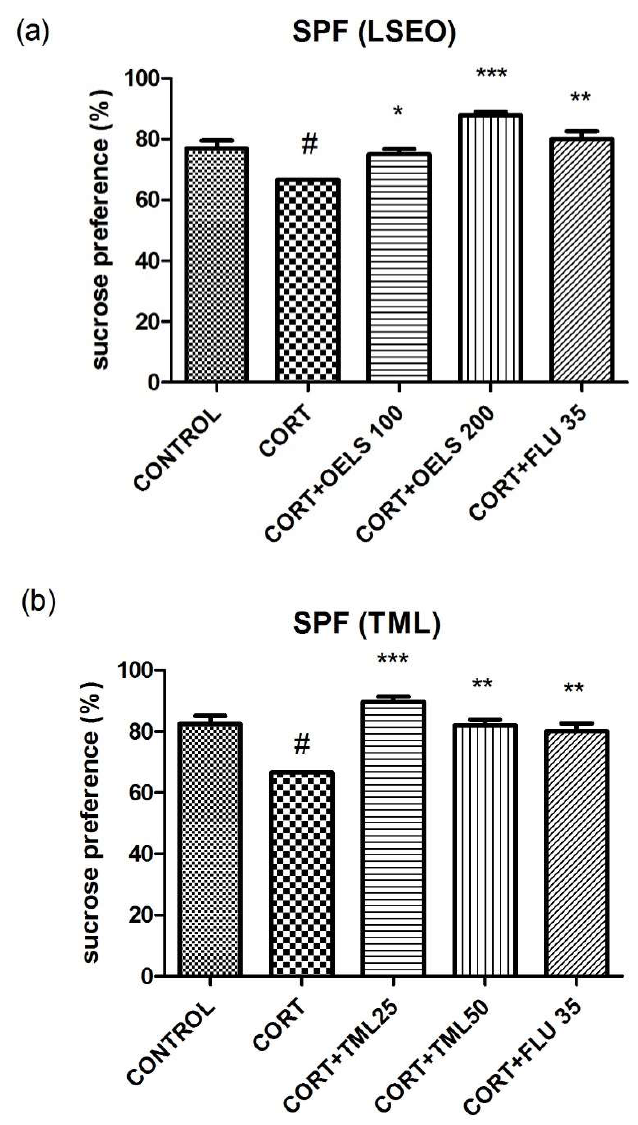
Figure 10. Effects of repeated administration of ( a ) LSEO (100 and 200 mg/kg; p.o.) and ( b ) TML (25 and 50 mg/kg; p.o.) in animals treated with CORT (22 days, 20 mg/kg, s.c.) on the sucrose preference (%). Values are expressed as the mean ± SEM ( n =10). Statistical analysis was determined by one-way ANOVA followed by the Student-Newman-Keuls test. Significant values: * p < 0.05, ** p < 0.001, *** p < 0.0001 vs. CORT; # p < 0.05 vs. control. LSEO = Lippia sidoides essential oil; TML = thymol; CORT = corticosterone; SPF = sucrose preference test.